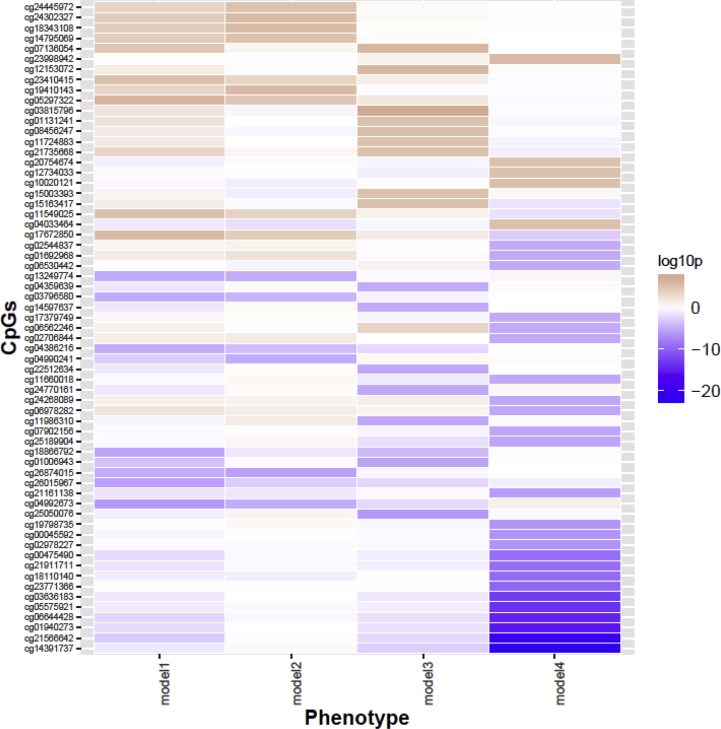
A heatmap to illustrate the direction and strength of association between all investigated passive smoking exposures and DNA methylation. Legend: Plotted CpGs are the top 50 CpGs with the smallest p-values in the passive smoking exposure single-site.